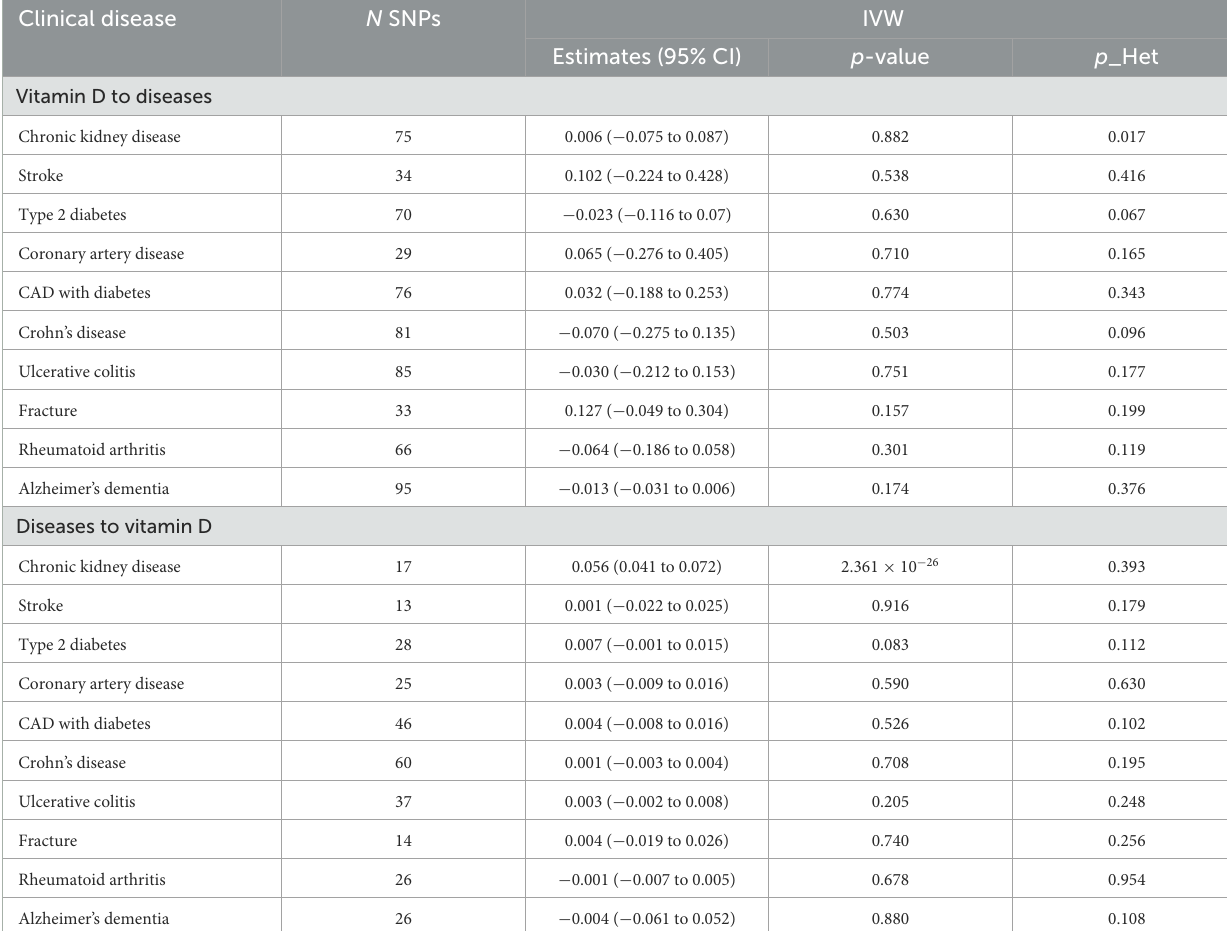
TABLE 2 Association of vitamin D with clinical diseases using inverse-variance weighting Mendelian randomization study. Clinical